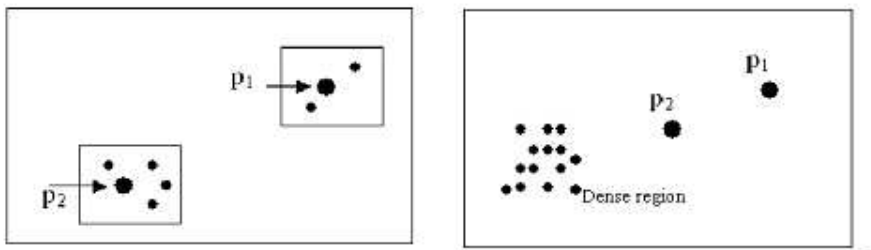
Figure 2. Local and global perspectives of outlier-ness of p